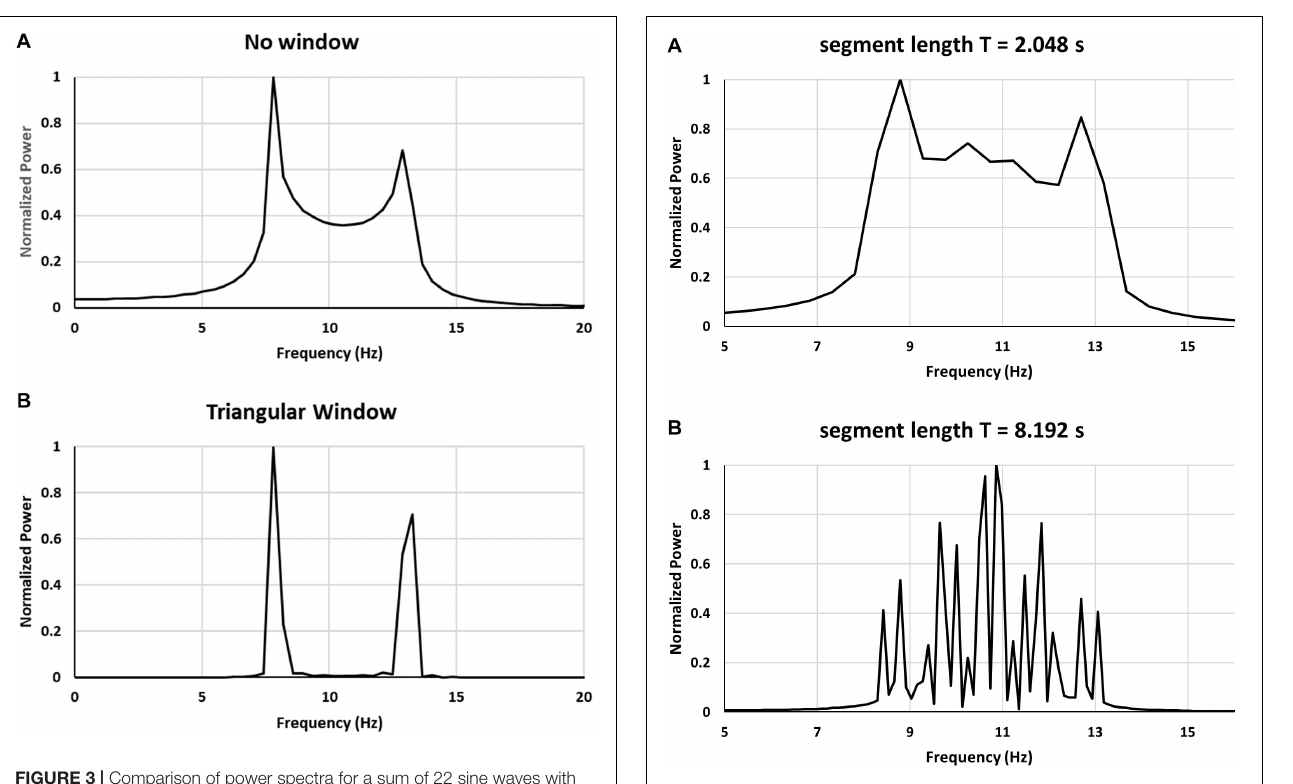
FIGURE 5 | Comparison of two power spectrum of the same multifrequency signal with two dominant frequencies for short and long segment